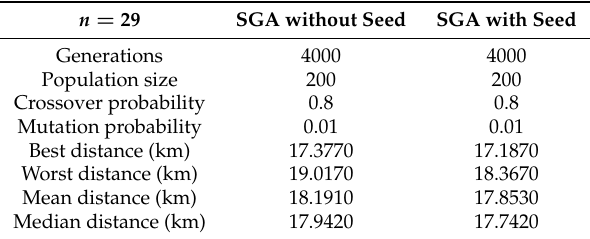
Table 10. Results of 10 executions n = 29 problem, SGA.